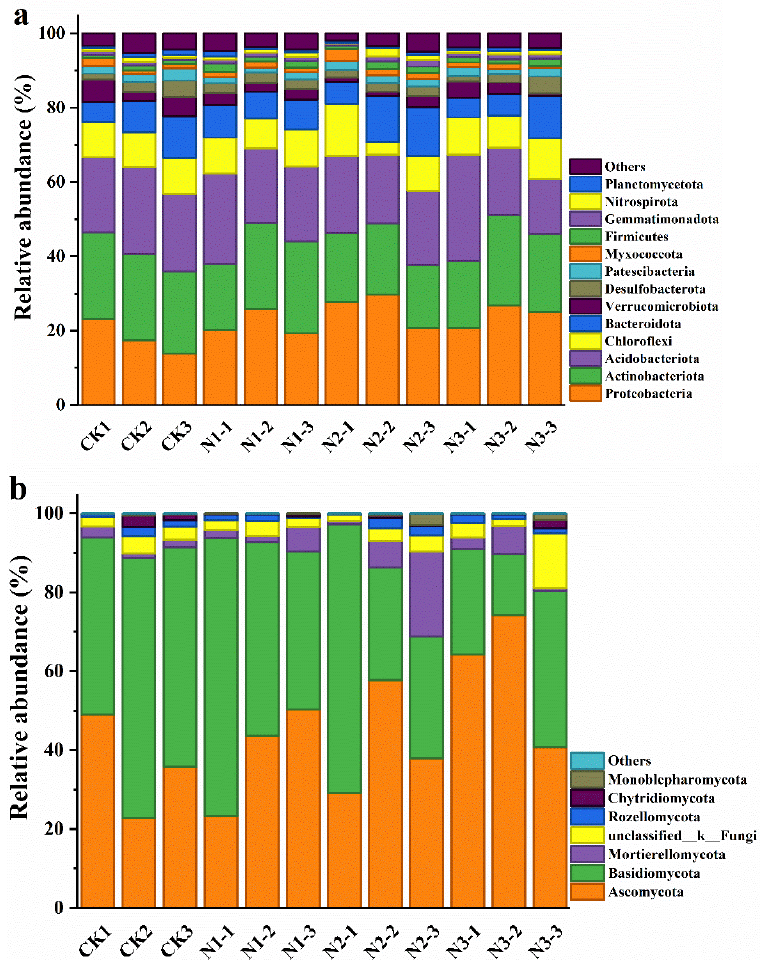
Figure 2. The effect of nitrogen addition on relative abundances of ( a ) bacteria phyla and ( b ) fungi phyla. Displayed are phyla with >1% relative abundance. Unclassified bacterial and fungal phyla < 1% abundance were grouped as “others”. CK1, CK2, CK3: 0 g N·m − 2 ·year − 1 ; N1-1, N1-2, N1-3: 6 g N · m − 2 · year − 1 ; N3-3: 24 g N · m − 2 · year − 1